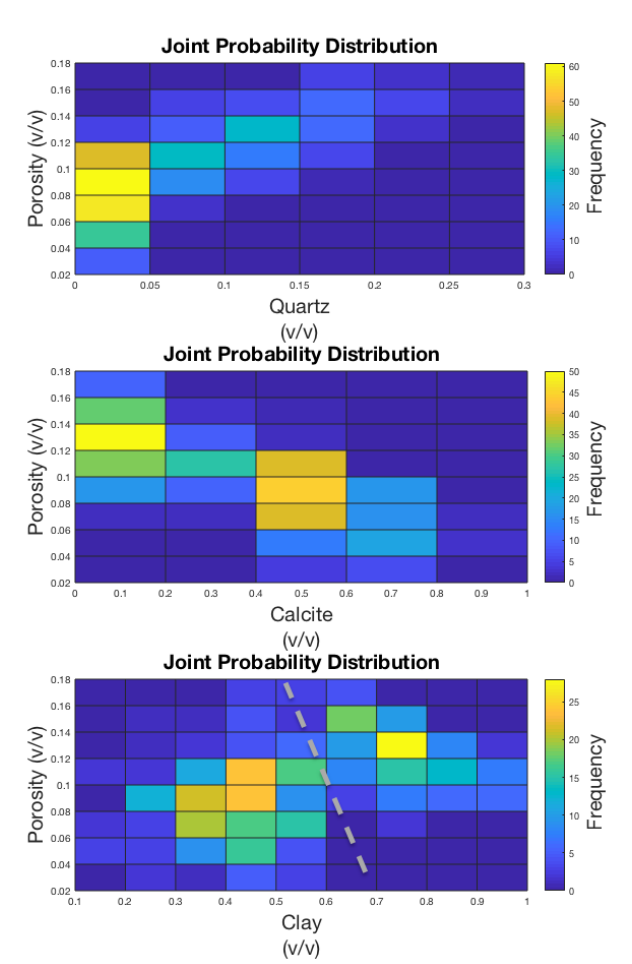
Figure 7. Joint probability distribution of measured porosity and rock constituents for the well in the Permian Basin. An increase in calcite can be observed to correspond to a decrease in porosity indicating the effect of calcite cementation. An increase in quartz content can be observed to correspond to an increase in porosity. The distribution of clay with porosity reflects the two zones (separated with the broken